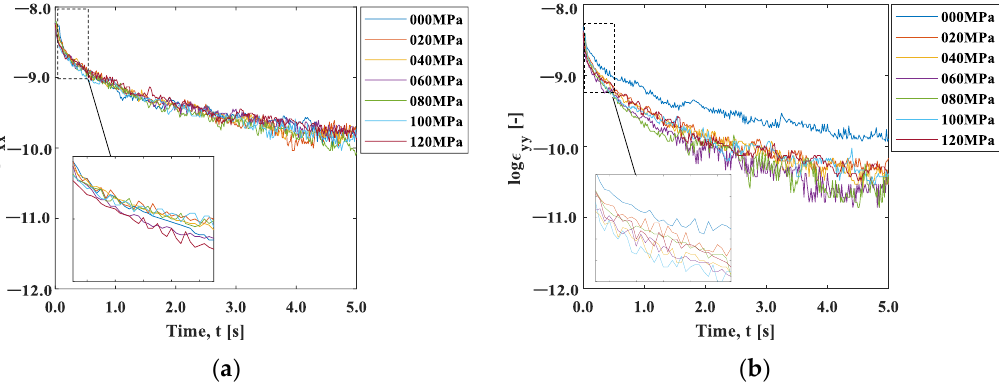
Figure 17. Time – log (strain) curve obtained using the ESPI: ( a ) 𝑥 -direction; and ( b ) 𝑦 -direction.